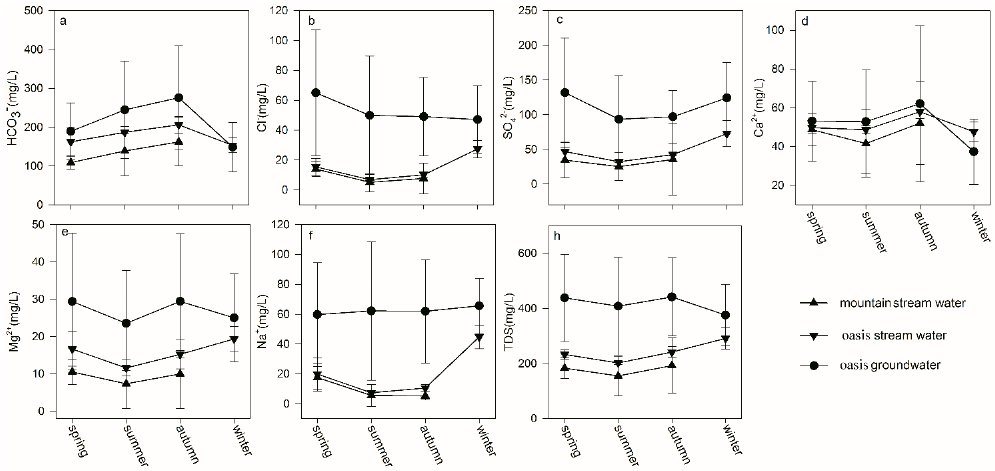
Figure 3. Piper diagrams of ( a ) stream water and ( b ) groundwater in different seasons.